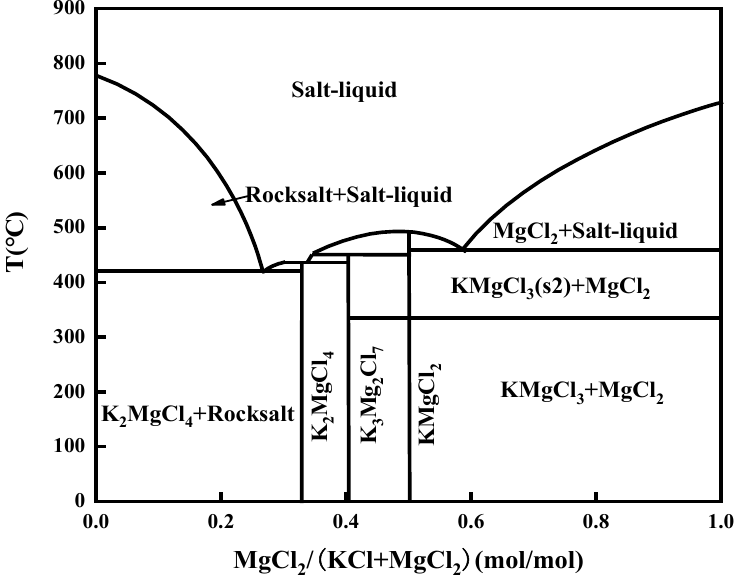
Figure 8. KCl + MgCl 2 phase diagram.